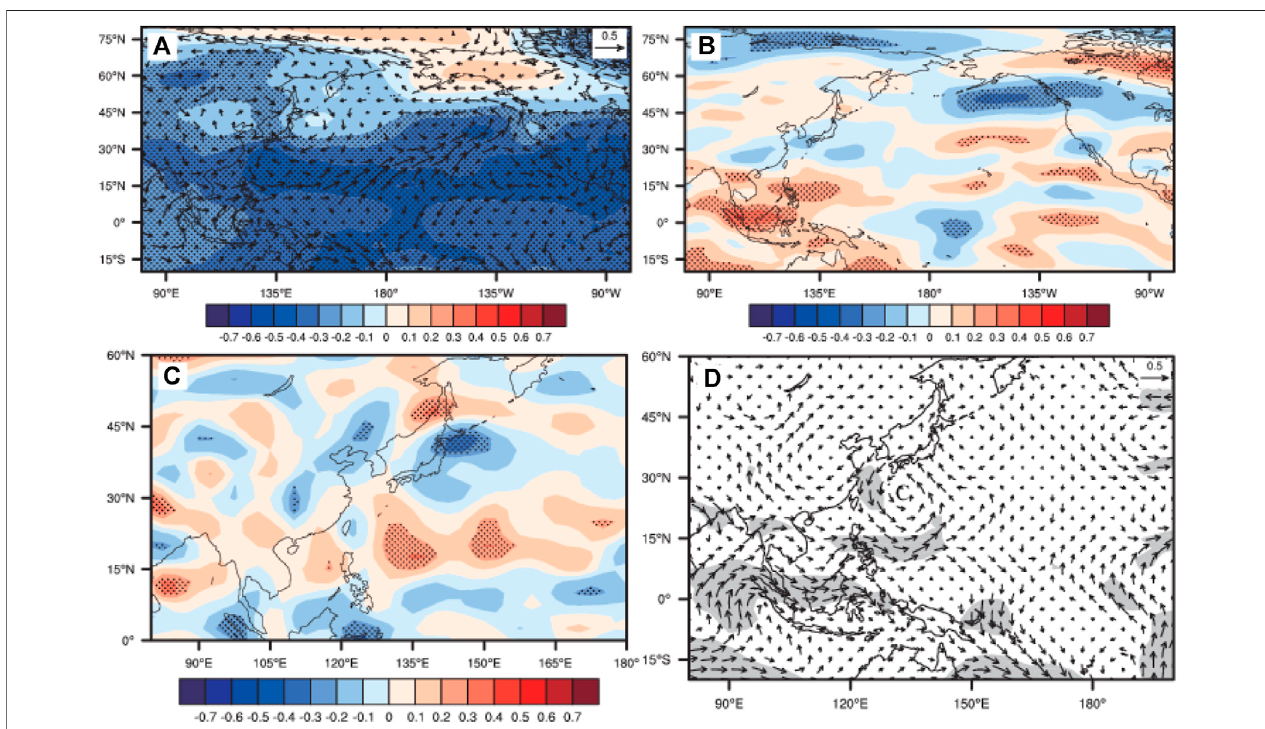
FIGURE 11 | The partial correlation coef fi cients between the sign-reversed Niño3 index in January – March and the (A) 500 hPa geopotential height anomaly (shading)and850 hPawindanomaly(vector), (B) 500 hPazonalwindanomaly, (C) 850 hPavorticityanomaly,and (D) steering fl owinJuly – September.Boththedotted areas and shaded areas indicate the correlations that are signi fi cant at the 90% con fi dence level.